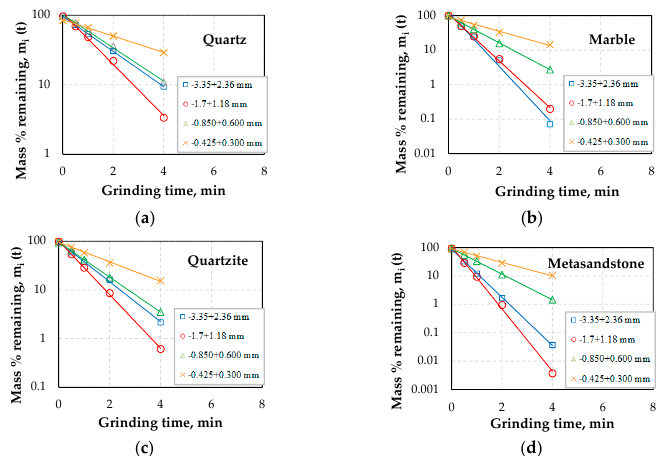
Figure 8. First order plots showing the mass % remaining for each size fraction of each material vs. grinding time; ( a ) quartz, ( b ) marble, ( c ) quartzite and ( d ) metasandstone.